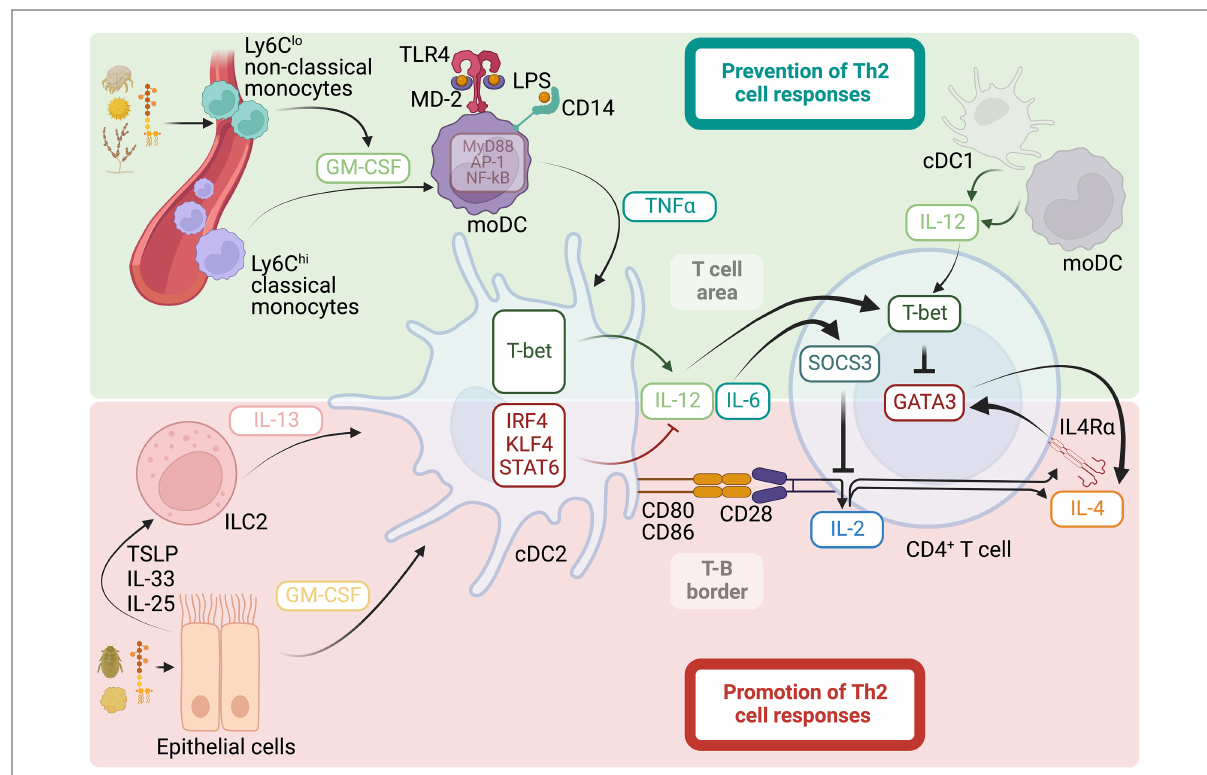
FIGURE 1 Mechanisms that promote and prevent Th2 cell responses to allergens. Promotion of Th2 cell responses: allergens with proteolytic activity, cytokines, and microbial products, such as LPS, can activate epithelial cells for subsequent release of the cytokines GM-CSF, TSLP, IL-33, and IL-25. This leads to the activation of ILC2s and the release of IL-13. GM-CSF and IL-13 stimulate the migration and expression of the transcription factors IRF4, KLF4, and STAT6 in cDC2s, ultimately promoting the functional specialization of the cDC2s to support Th2 cell differentiation by reducing the ability of the cDC2s to produce IL-12, while retaining their co-stimulatory ability to foster strong IL-2 responses in CD4 + T cells. Strong and sustained IL-2 signaling in the absence of IL-12 promotes Th2 cell lineage commitment by promoting the expression of IL-4R α and IL-4, allowing for an IL-4- positive feedback loop that initiates and preserves the Th2 cell phenotype. Prevention of Th2 cell responses: allergens with cysteine protease activity stimulate GM-CSF release from perivascular Ly6C lo non-classical monocytes, guiding the differentiation of Ly6C hi classical monocytes into moDCs. GM-CSF licenses an in fl ammatory signature in moDCs by increasing the expression of TLR4, CD14, and intracellular signaling members involved in the MyD88/NF-kB/AP-1-dependent pathway. Functional programming of moDCs by GM-CSF allows these cells to increase their sensitivity to LPS and stimulate the production of the pro-in fl ammatory cytokine TNF α , which guides cDC2 activation for Th2 cell suppression rather than promotion. In particular, TNF α induces the expression of the transcription factor T-bet in cDC2s, which is intrinsically necessary for the ability of cDC2s to produce sustained IL-12 and suppress Th2 cell priming by inducing T-bet and inhibiting GATA3 in CD4 + T cells. cDC2s can also produce IL-6, upregulating SOCS3 in CD4 + T cells and ultimately suppressing IL-2 signaling and early Th2 cell commitment. cDC1s and moDCs are additional sources of IL-12 that contribute to the suppression of Th2 cell